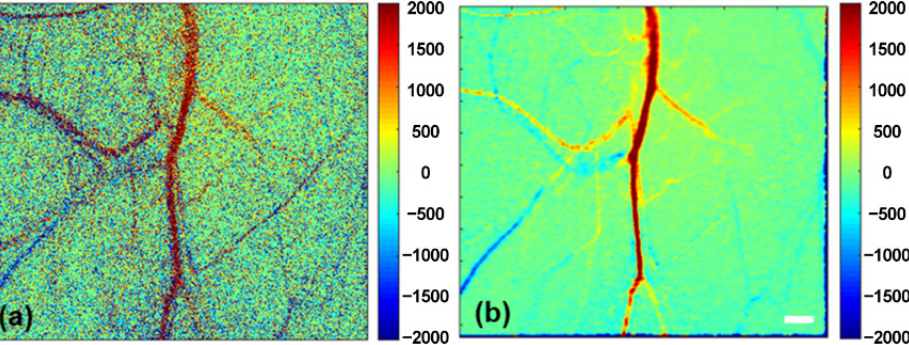
Figure 11. SFI difference image processed by the tLSCI without/with introducing ADF (scale bar = 100 µm). ( a ) tLSCI, ( b ) tLSCI with introducing ADF. 3.6. Blood-Flow Monitoring during Laser Irradiation Using the SFI The variation of the SFI over time in each frame can be used to monitor the hemody- namic changes during the transient thermal response of the blood vessel. The incident laser energy density is 57 J/cm 2 , and the repetition rate is 4 Hz. The pulse width is 0.3 ms, and the spot diameter is 3 mm. Figure 12 shows the SFI variation with laser pulse (red line) and the SFI images in important instants. The blood vessels are intact before laser irradiation in Figure 12a. Firstly, four pulses were fired to generate the thrombus. After 2.5 s, 10 more pulses were fired to occlude the vessel. The target vessel is pointed by the orange arrow in the Figure 12b (frame index: 20), and the black rectangle area is monitored by the SFI. The regions of interest are circled in red. As shown in Figure 12a, the blood-flow rate